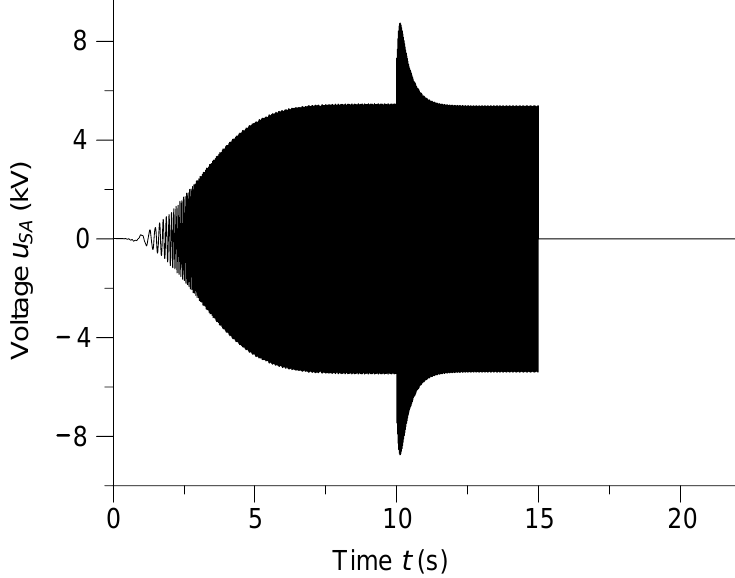
Figure 5. Instantaneous A-phase voltage of the shaft generator armature. During the start-up of the ship’s propulsion, the generator armature winding was opened. The shaft generator was accelerating when idle. After reaching the rated voltage, the generator was loaded. In order to maintain the rated value of the armature voltage when the electrical load is applied, the excitation voltage of the generator is increased. At the time t = 10 s, the voltage value at the shaft generator terminals increased by 50%. This voltage step is associated with an increase in the electromotive force (EMF). Consequently, this causes an increase in the generator’s currents and electromagnetic torque. When the generator goes into a short-circuit condition, the voltage at the armature terminals drops to zero. During the system start-up, the armature winding was open; therefore, the current in the armature winding did not flow (Figure